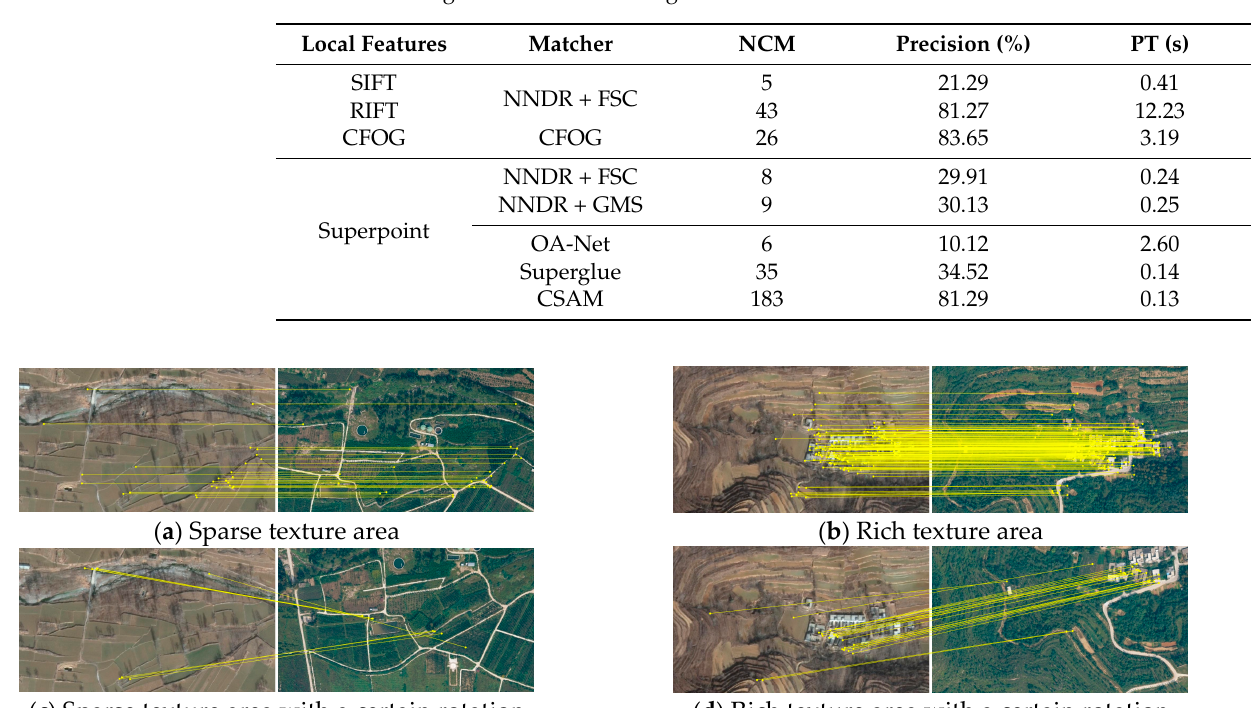
Table 1. Matching results of different algorithms on the test dataset.